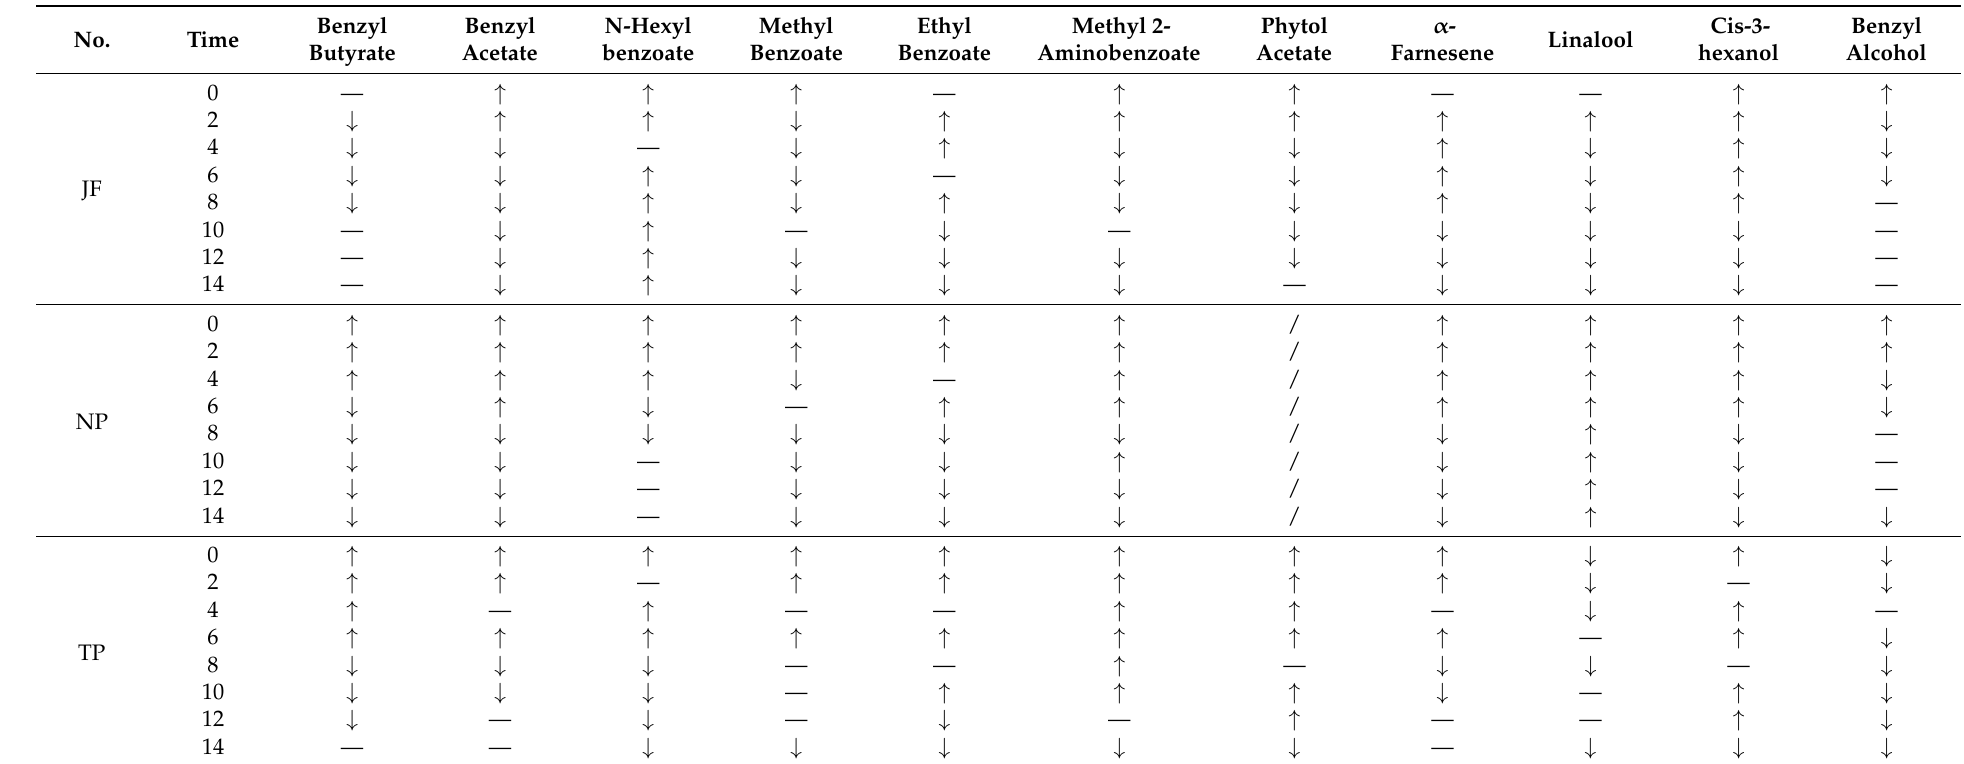
Table 1. Changes in differential volatile